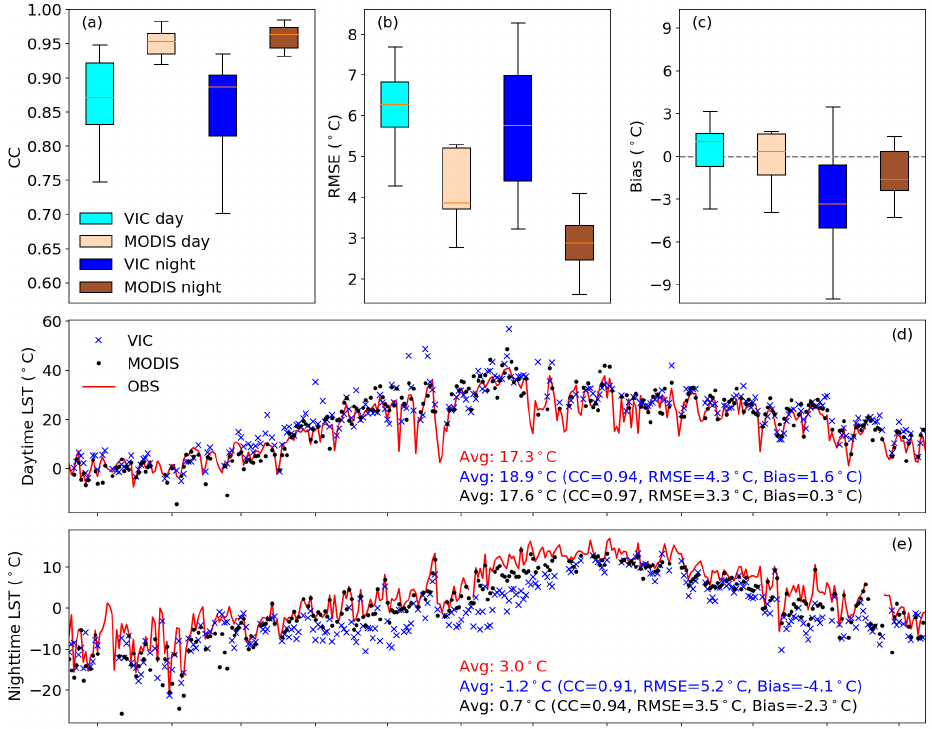
Figure 4. (a–c) Box plots of CC, RMSE, and bias comparing VIC and MODIS LST to observations at 14 sites. Time series of daytime (d) and nighttime LST (e) at one site (station ID “FuF”, whose location is shown in Fig. S2).